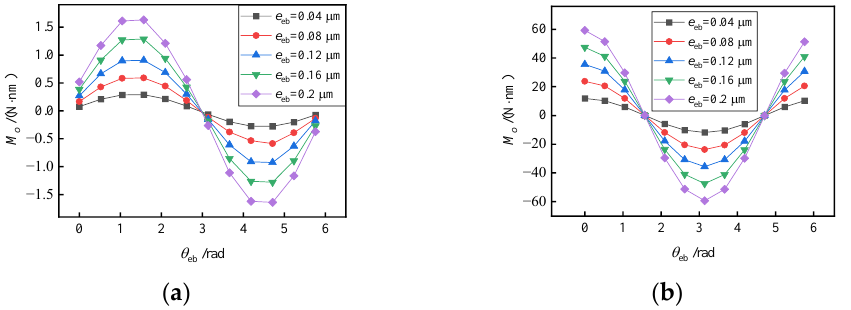
Figure 15. Interference torque versus eccentricity of the axis. ( a ) with f = (10 0 0) m/s 2 ( b ) with f = (0 0 10) m/s 2 .